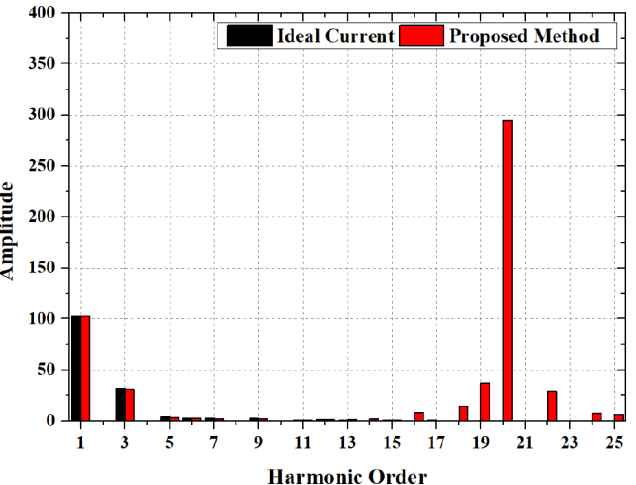
Figure 10. Iron loss comparison between the ideal current source analysis and the proposed method in case 5.